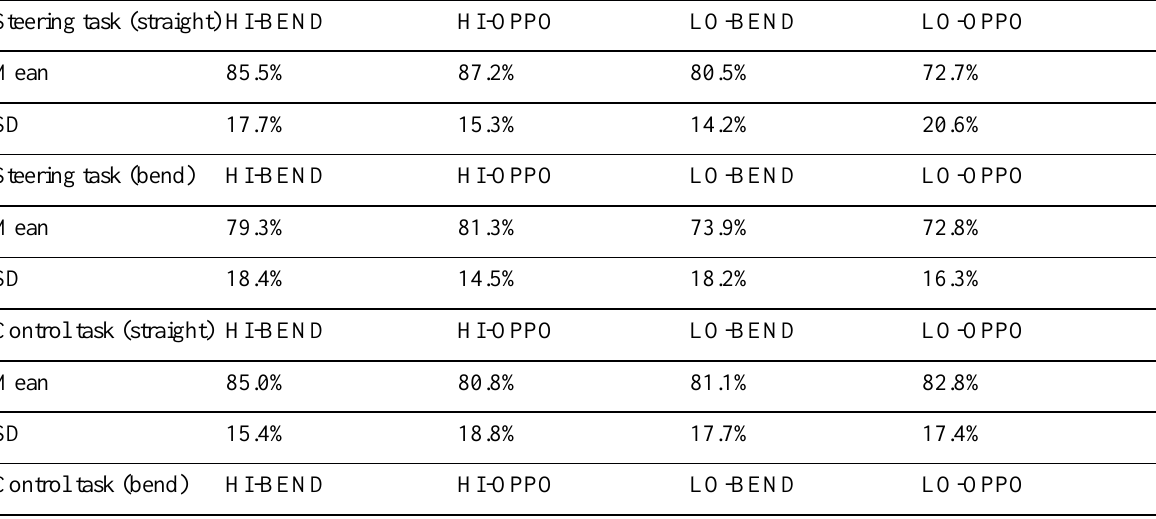
Table 1. Mean detection rates and standard deviations for the different target locations in straights and bends in both the steering and control